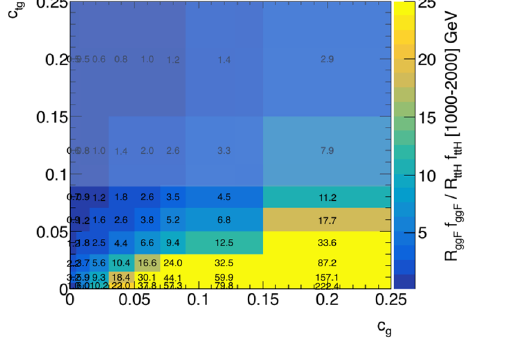
Figure 2. Ratios of EFT yields normalised to SM predictions in the ggF to t ¯ tH production processes in the intervals 450 < p H < 650 GeV (top left), 650 < p H < 1000 GeV (top right) and T T 1000 < p H < 2000 GeV (bottom center), weighted by the signal fractions f ggF =0.50 and f =0.15 t ¯ tH T of ggF and t ¯ tH accepted signal events, respectively, corresponding to the values reported for the ATLAS and CMS analyses. The blue shaded area indicates the range of c tg values excluded by the fit of top observables of ref. [71] translated to our definition of c tg ( µ 0 ) for µ 0 = 125